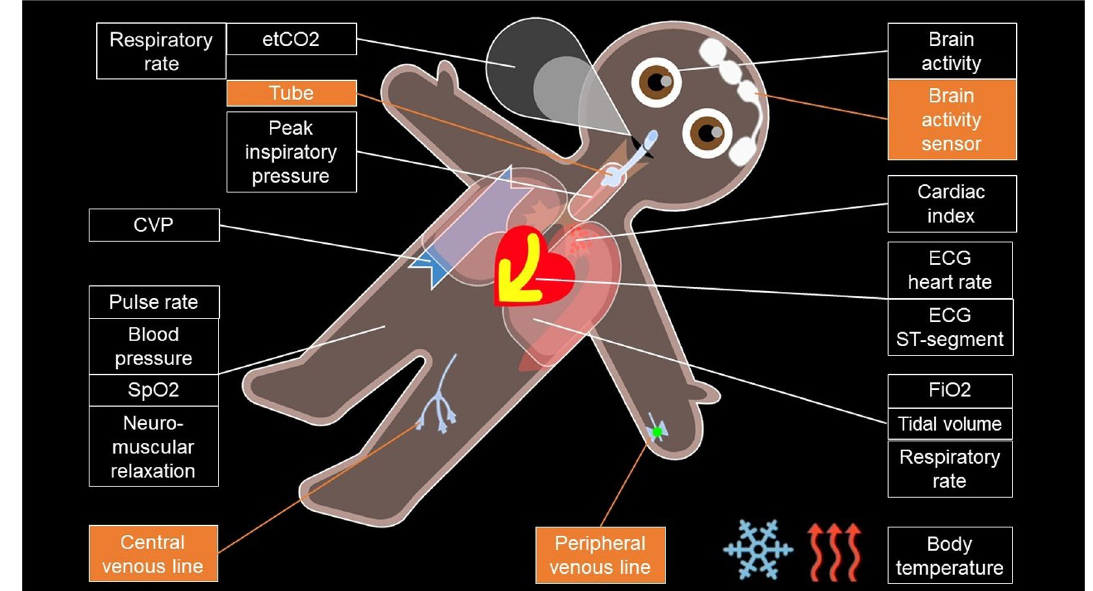
Figure 1. Visual-Patient-avatar ICU displaying the fifteen currently available vital signs and selected installations (orange boxes). When body temperature deviates from the normal range, heat waves or ice crystals appear around the avatar. CVP central venous pressure, ECG electrocardiogram, etCO2 end-tidal carbon dioxide, FiO2 inspiratory oxygen concentration, SpO2 peripheral oxygen saturation. Additional File 1 shows all available installations as a table. Pulse rate and ECG heart rate were merged and counted as one item in the study.